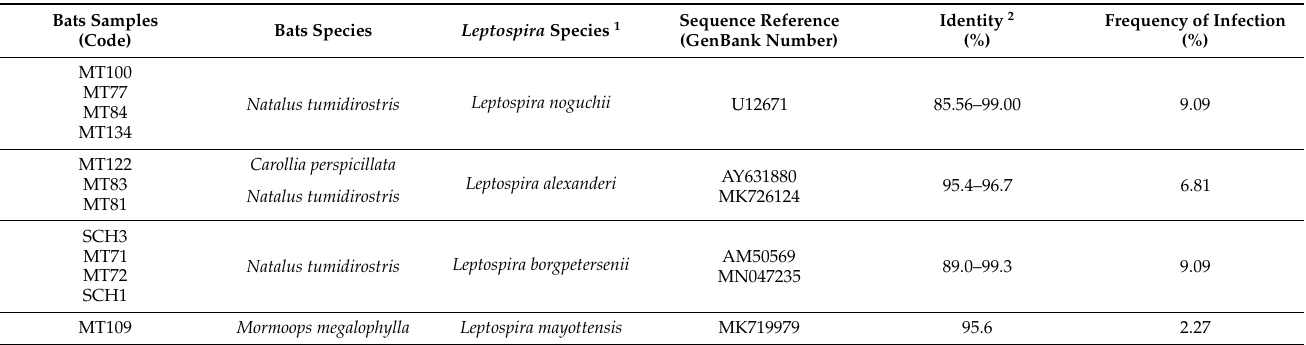
Table 3. Leptospira species identified in Macaregua Cave bats.